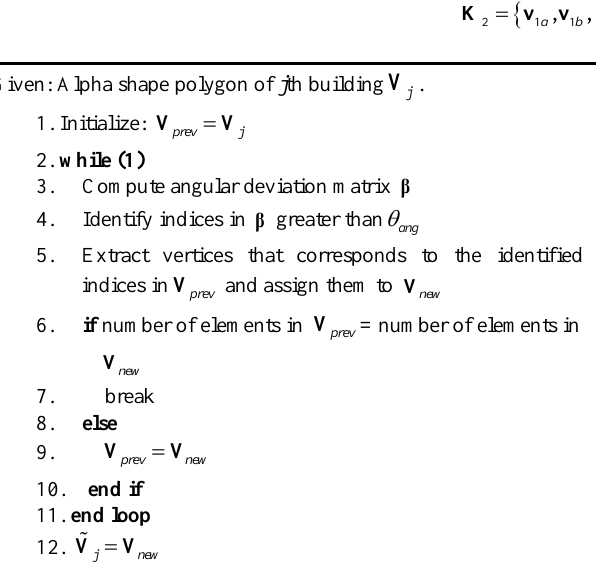
Figure 1: Illustration of the concept of vertices v with four reconstructed façades 1,..., k m  longest paths associated for a particular façade